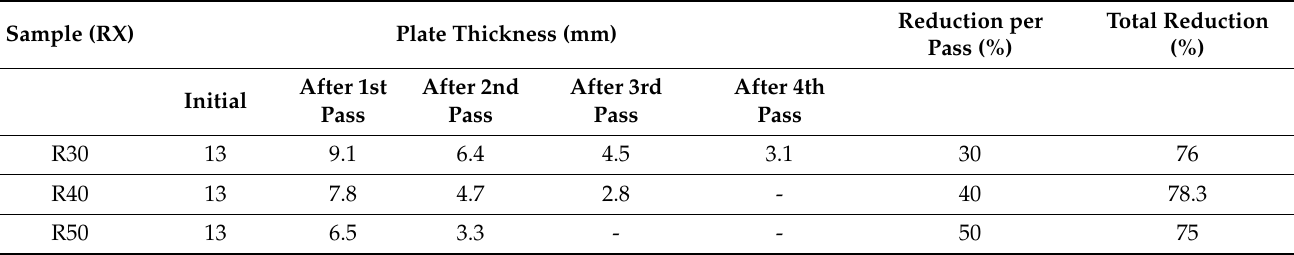
Table 2. Rolling schedule for the investigated